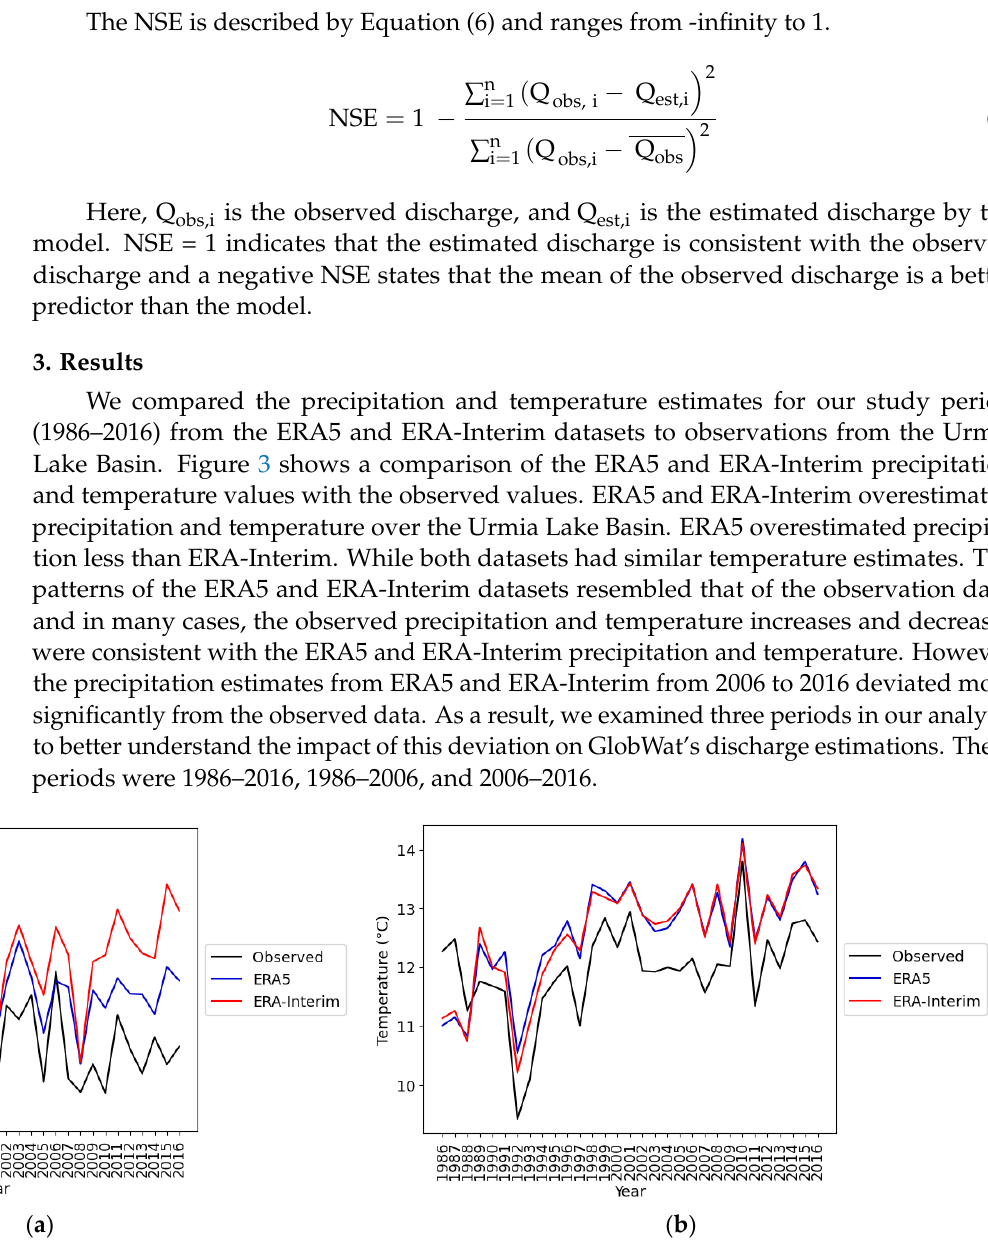
Figure 3. ( a ) Comparison of observed precipitation in the Urmia Lake Basin and ERA5 and ERA- Interim precipitation; ( b ) Comparison of observed mean annual temperature in the Urmia Lake Basin and ERA5 and ERA-Interim mean annual temperature.